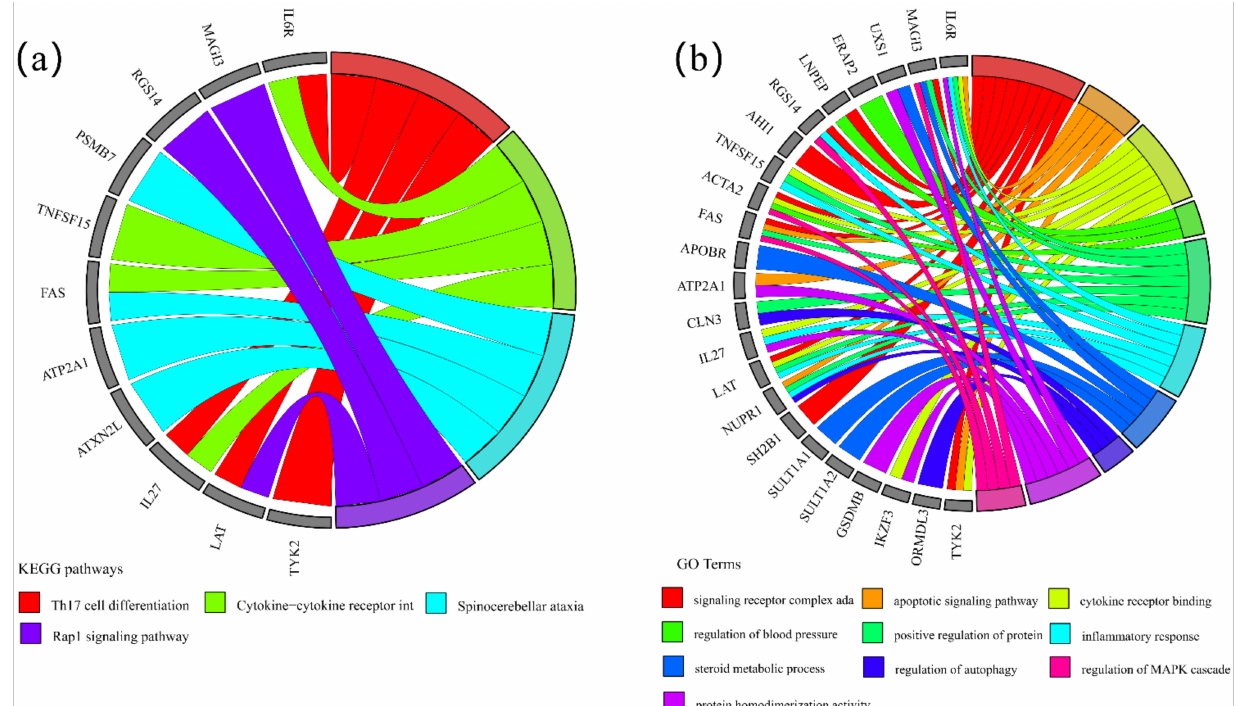
Figure 3. Chord graphs for four significant KEGG pathways and ten significant GO terms. ( a ) Chord graph of four significant KEGG pathways. ( b ) Chord graph of ten significant GO terms. For each panel, the right semicircle represented significant pathways or terms, and the left semicircle represented the genes enriched in these pathways or terms.